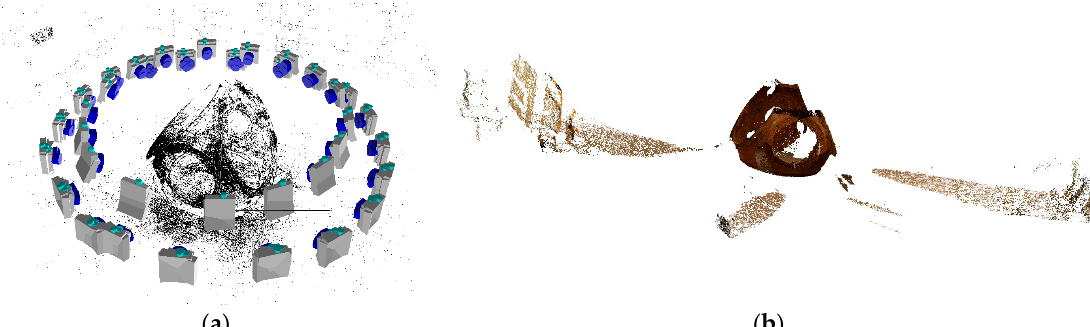
Figure 10. Dense matching schema for shop-floor case study: ( a ) structure from motion; and ( b ) dense 3D colorized point cloud without filtering.